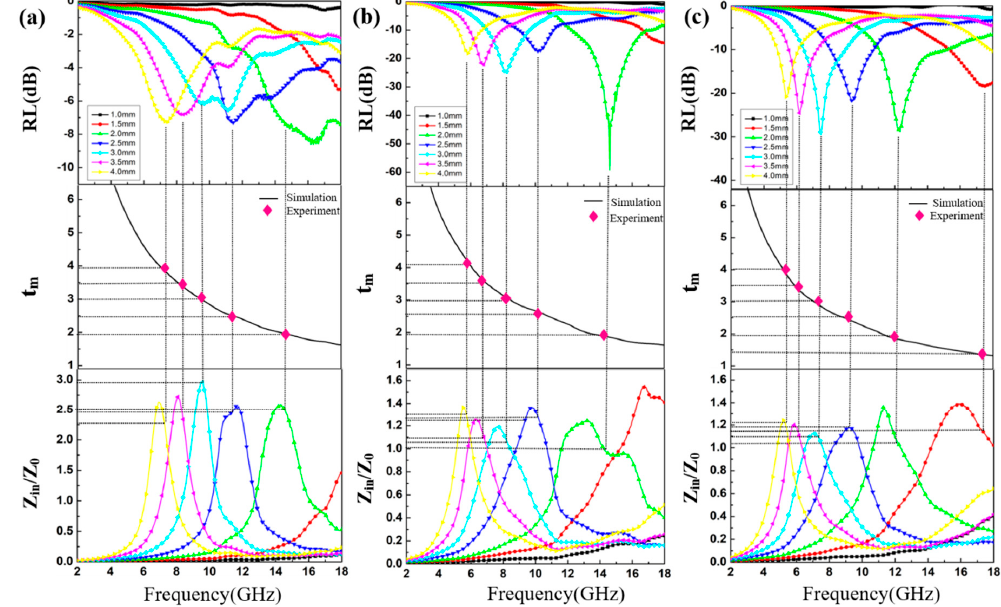
Figure 10. The RL curves, the matching thickness ( t m ) under λ / 4 conditions and impedance matching of CoS@Ti 3 C 2 T x with di ff erent filler loadings: 35 wt % ( a ), 40 wt % ( b ), and 45 wt % ( c